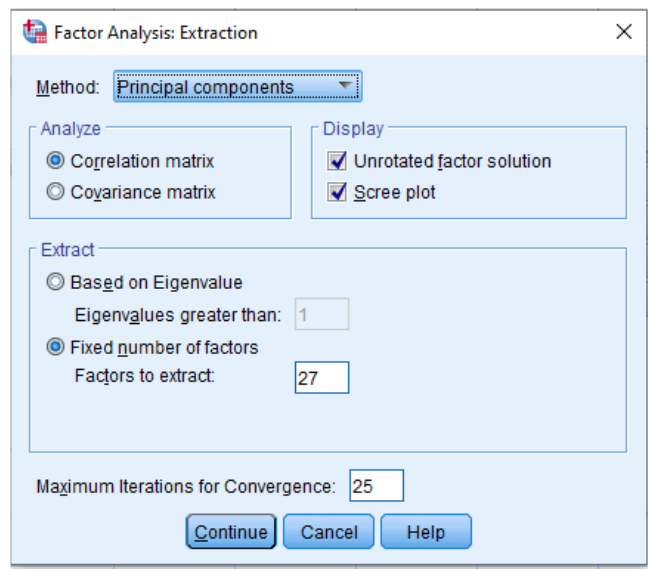
Figure 17. Setup of factorial analysis in SPSS to extract principal components.